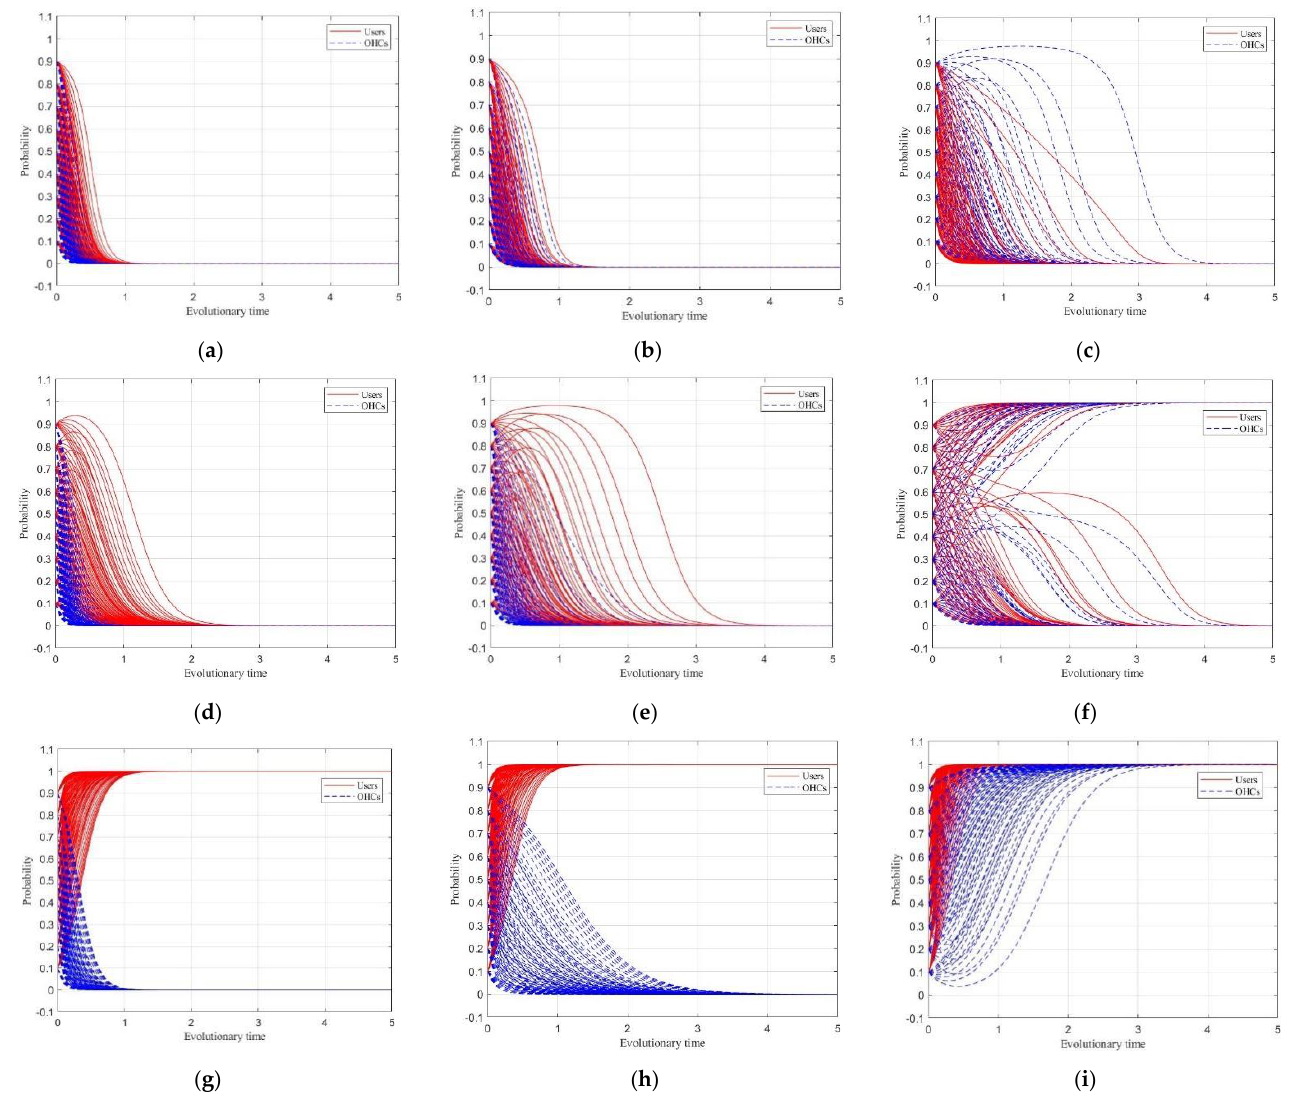
Figure 5. Numerical simulation of Scenarios 1 to 9. ( a ) Simulation of Scenario 1; ( b ) Simulation of Scenario 2; ( c ) Simulation of Scenario 3; ( d ) Simulation of Scenario 4; ( e ) Simulation of Scenario 5; ( f ) Simulation of Scenario 6; ( g ) Simulation of Scenario 7; ( h ) Simulation of Scenario 8; ( i ) Simulation of Scenario 9.